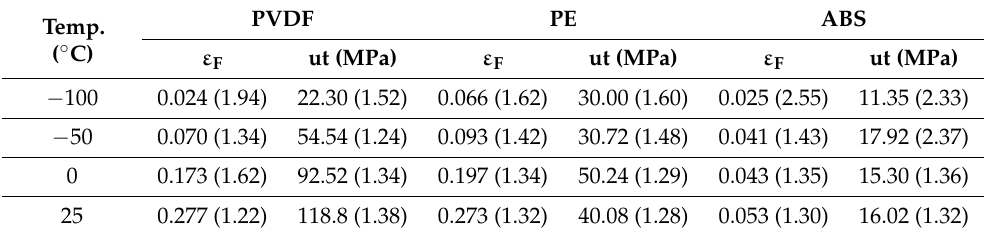
Table 3. Fracture strain and modulus of toughness from temperature-dependency tests. Temp.